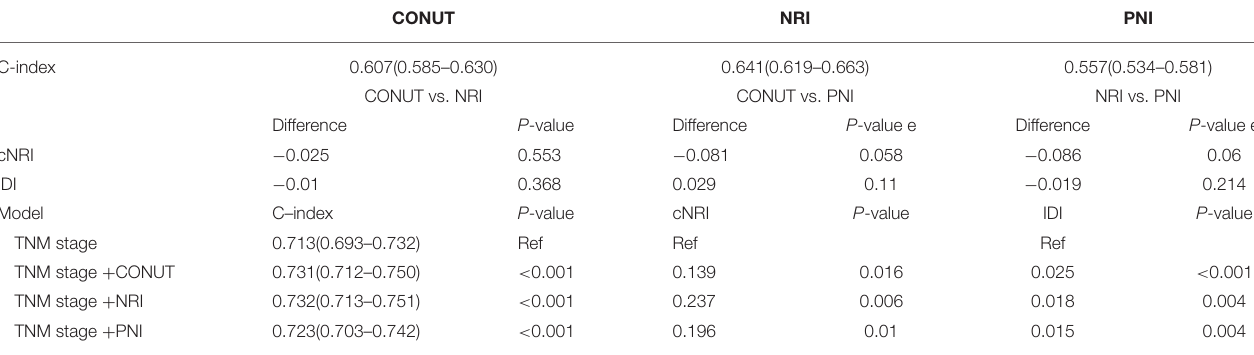
TABLE 3 | Comparative analysis of the discrimination and model performance of each malnutrition index for all-cause